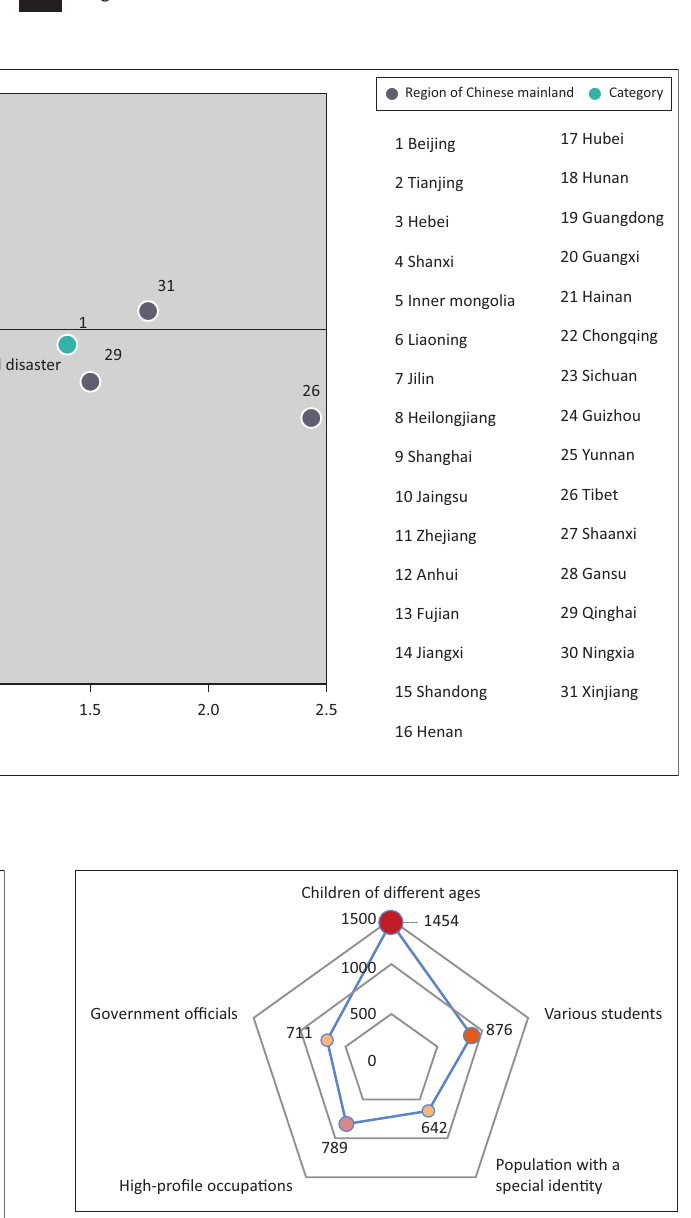
FIGURE 7: Different types of risk populations of